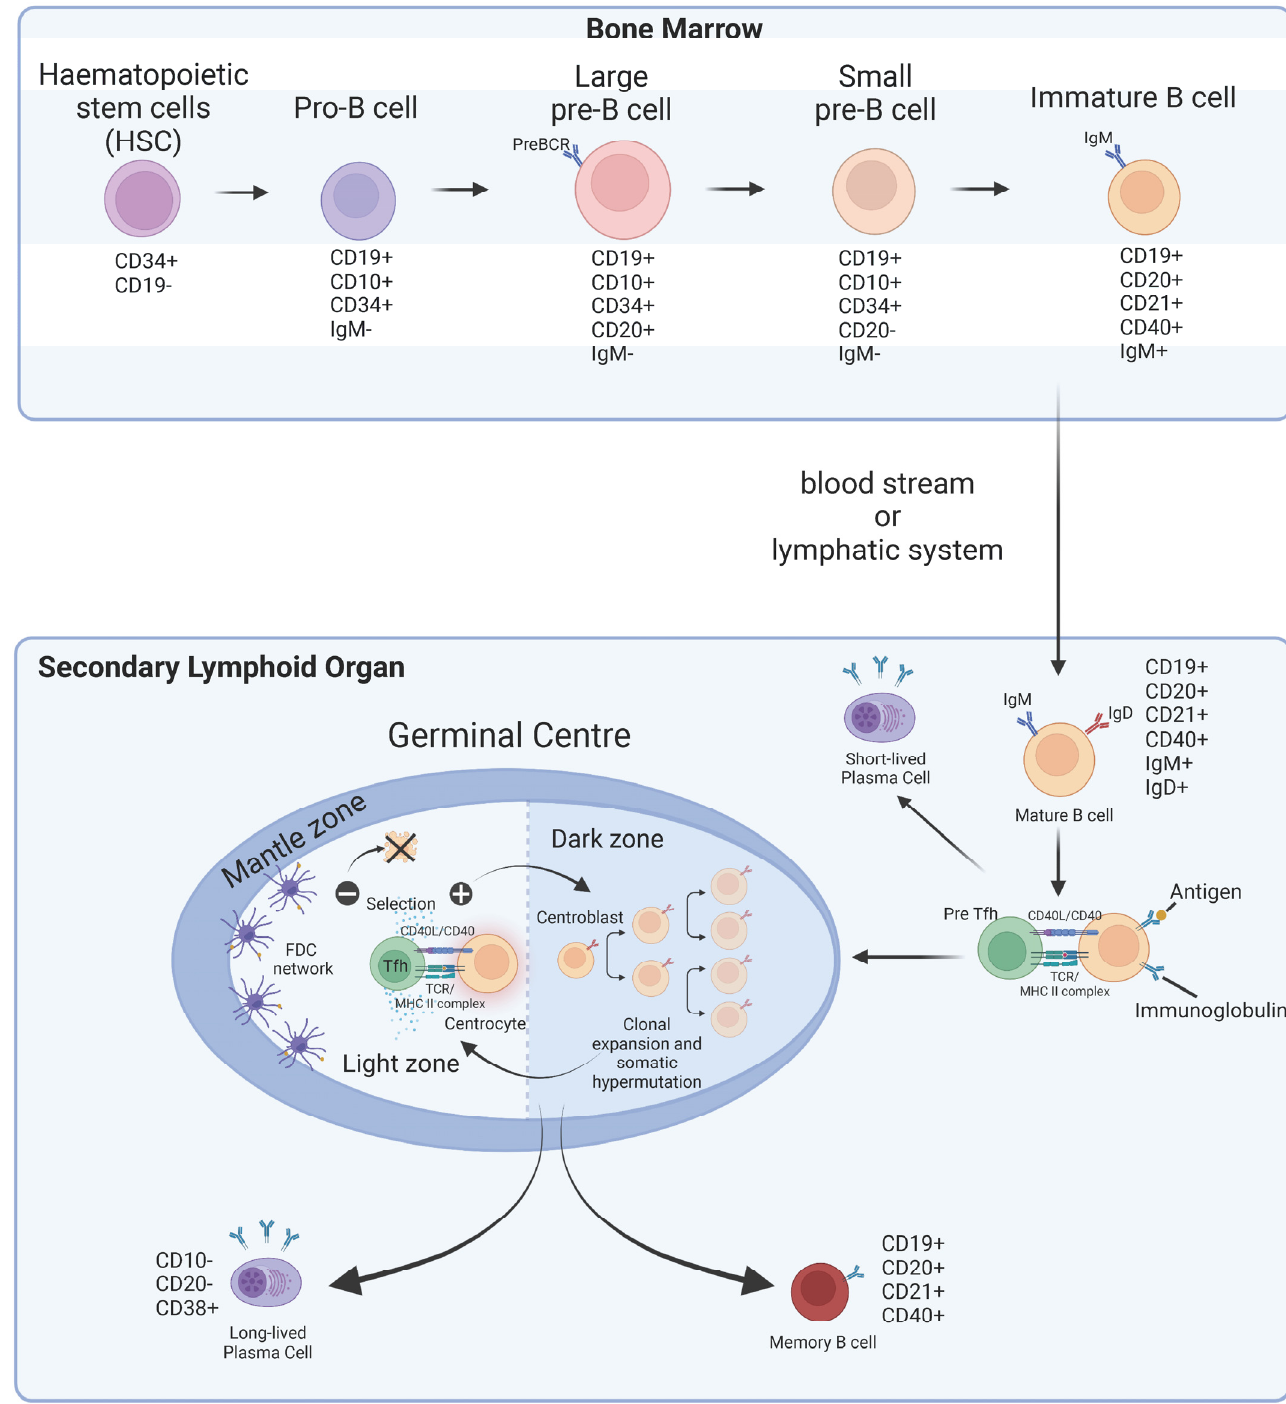
Figure 1. B cell development and differentiation. B cells primarily originate from CD34+CD19 − haematopoietic stem cells within the bone marrow, where rearrangement of immunoglobulin heavy and light chains through V(D)J recombination leads to the development of functional IgM+ immature B cells. Those that survive tolerance checks to prevent autoreactivity migrate through the bloodstream or lymphatics to secondary lymphoid organs. Following exposure to cognate antigen, mature B cells can undergo plasmacytic differentiation to generate short-lived plasma cells or establish a germinal centre reaction. Within the germinal centre, B cells undergo iterative rounds of somatic hypermutation and selection through interactions with follicular T helper (Tfh) and follicular dendritic cells (FDC). The resultant B cell pool will exit the germinal centre as high-affinity memory B or plasma cells.